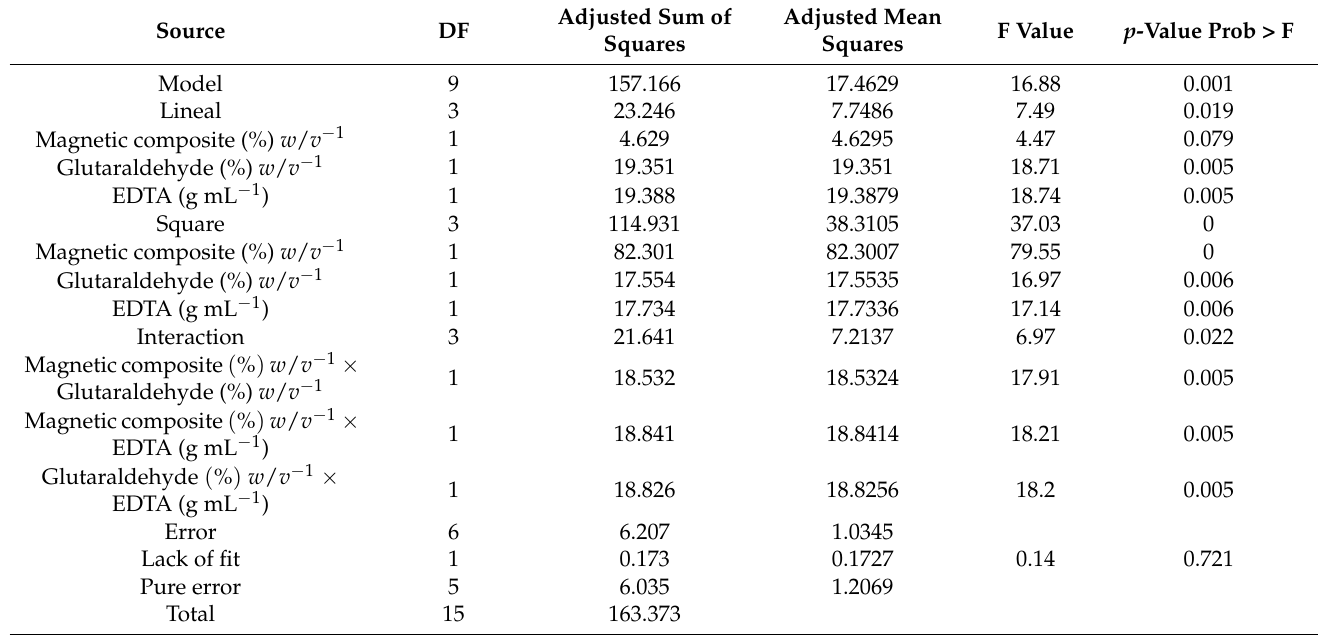
Table 1. Analysis of variance (ANOVA) of the response surface methodology for the synthesis of the Sargassum magnetic composite with the composite, crosslinked with glutaraldehyde, and functionalized with EDTA, maximizing the adsorption capacity of Hg 2+